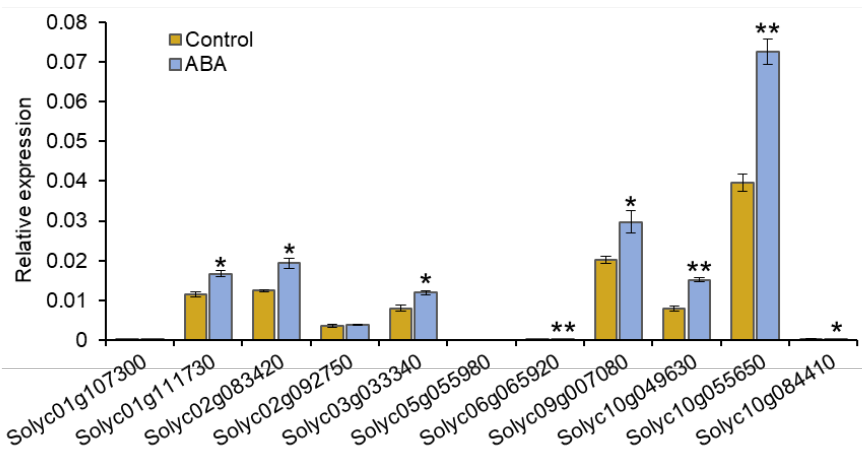
Figure 2. ABA-induced expression patterns of SlPP2C.D genes in tomato seedlings. Four-day-old tomato seedlings grown on half-strength Murashige and Skoog (MS) agar medium in dark were subsequently treated with 0.01 µ M ABA for three hours. Total RNA was used for qRT-PCR. The tomato ACTIN2 gene was used as an internal standard. Values are means ± SD of three biological replicates. Asterisks refer to data significantly different from 0 µ M ABA (Control); Student’s t -test: * p < 0.05, ** p < 0.01.